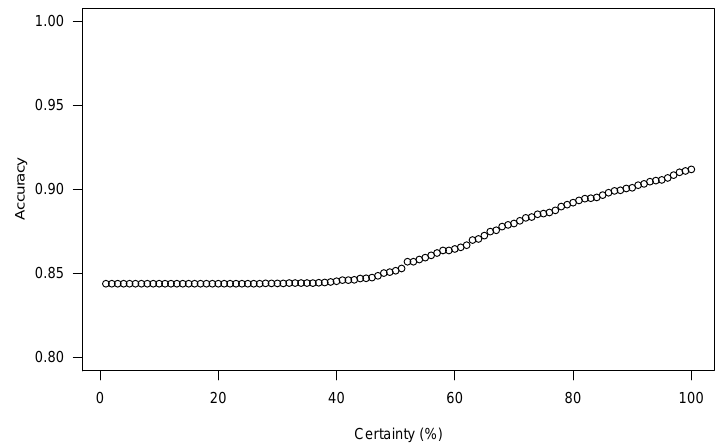
Figure 6. The accuracy was calculated by masking out pixels with lower accuracy values.